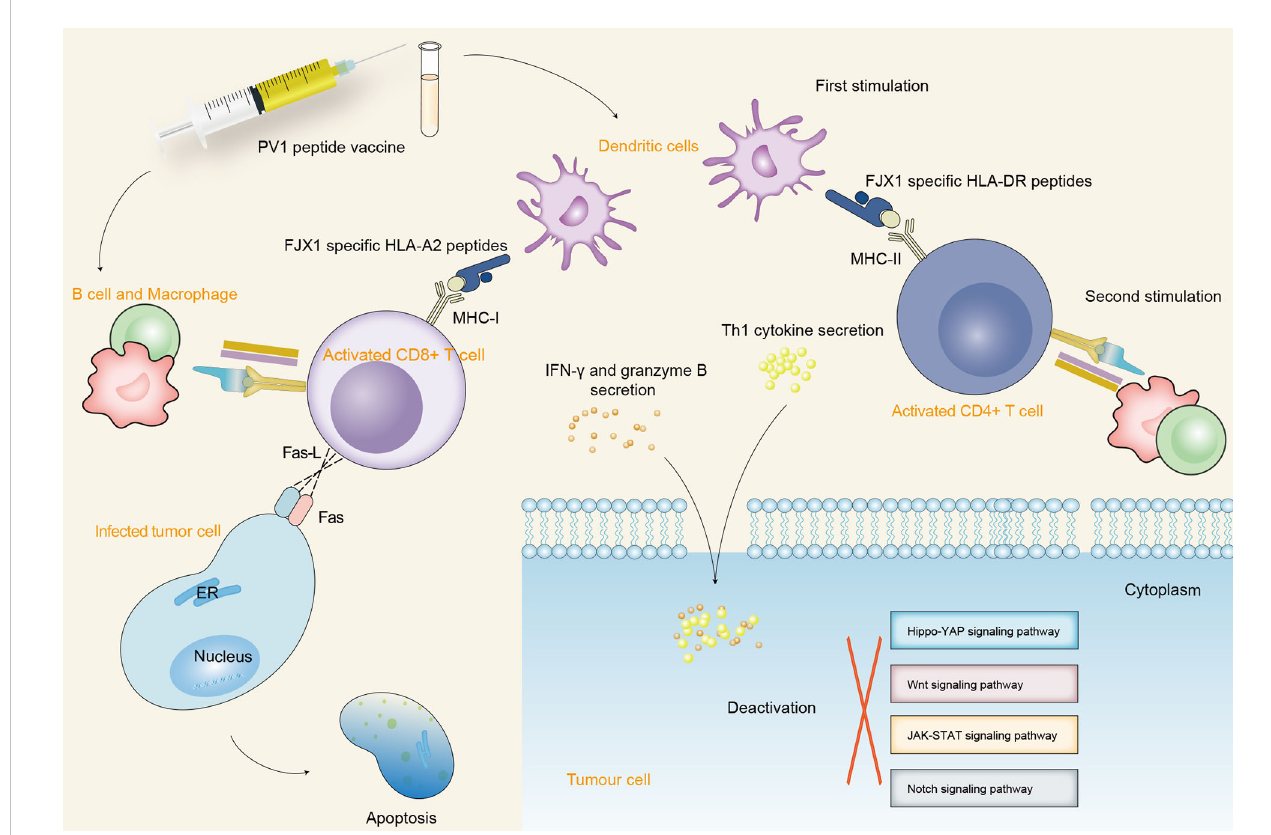
FIGURE 4 The schematic diagram depicts the immunogenic mechanism of SPKKP-related antigen-speci fi c peptide vaccine in cancers. Dendritic cells participate in the fi rst process of antigen presentation after vaccination, making FJX1-speci fi c HLA-DR and HLA-A2 peptides recognize the speci fi c surface antigen of CD4 + T cells and CD8 + T cells, respectively. Furthermore, B cells and macrophages activate T cells to produce a long-lasting killing effect and promote the secretion of cytotoxic cytokines. The interaction between Fas-L expressed by CD8 + T cells and Fas expressed by target cells promotes the direct apoptosis of tumor cells. The secreted cytotoxic cytokines further inactivate a variety of oncogenic signaling pathways and induce the apoptosis of tumor